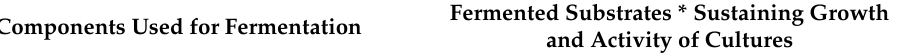
Table 2. Fermented foods prepared from substrate derived from plant and animal sources (source of information compiled in the table from references